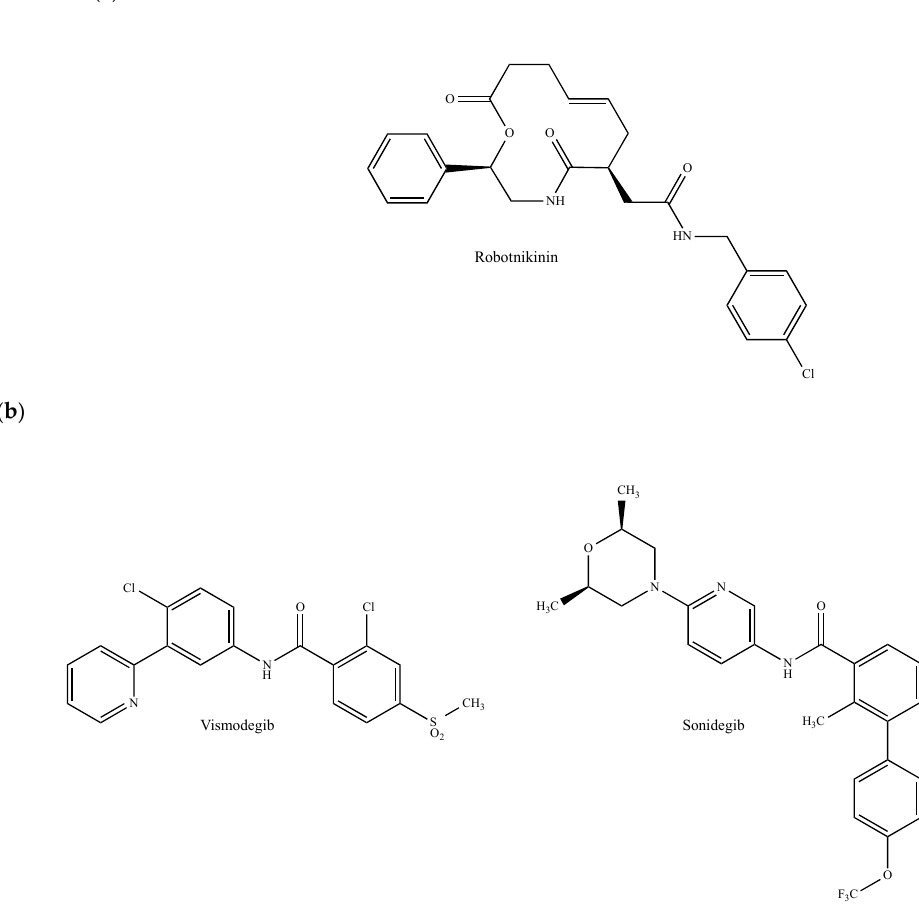
Figure 12. Structure of the compounds interfering with Hedgehog pathways: ( a ) robotnikinin, which binds the extracellular Sonic Hedgehog (SHH) protein and ( b ) vismodegib and sonidegib. Wnt proteins are a group of highly conserved secreted glycoproteins that are critical for embryo development and adult tissue homeostasis. Frizzled (FZD) proteins, which are seven transmembrane receptors for Wnt ligands and the Wnt co-receptors (namely low-density-lipoprotein receptor-related proteins 5/6 (LRP5/6)) are required for Wnt β -catenin-dependent and -independent signaling pathways [260,261]. The overactivation of Wnt signaling pathways is also implicated in several human diseases including colorectal, hematological and breast cancers [262]. Wnt signaling is activated in over 50% of breast cancer patients and is associated with reduced overall survival [263] and metastasis in TNBCs [264]. Moreover, canonical Wnt ligands and receptors, including FZD7, are frequently overexpressed in breast cancers, while secreted antagonists are silenced [265–267].